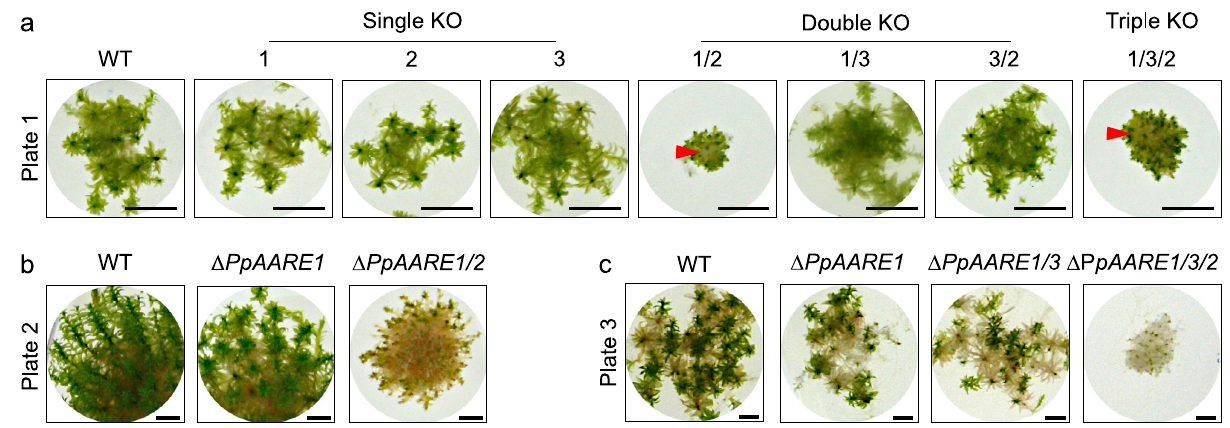
Fig. 4 Physcomitrella gametophore colonies of varying age. a Colonies of all representative knockout mutants after 5 months on solid medium (KnopME). Bar = 5 mm. Gametophores of Δ PpAARE1/2 and Δ PpAARE1/3/2 are only viable at the tip, whereas plant material at the base (red arrow) is dead. b Colonies after 8 months on solid medium. Δ PpAARE1 is the parental line for Δ PpAARE1/2 . Gametophores of WT and Δ PpAARE1 are still viable whereas Δ PpAARE1/2 gametophores are mostly dead. Bar = 2 mm. c Colonies after 8 months on solid medium. Δ PpAARE1 is the parental line for Δ PpAARE1/3 and Δ PpAARE1/3 is the parental line for Δ PpAARE1/3/2 . Colonies of WT, Δ PpAARE1 and Δ PpAARE1/3 still have viable gametophores, whereas Δ PpAARE1/3/2 gametophores are dead. Bar = 2 mm.